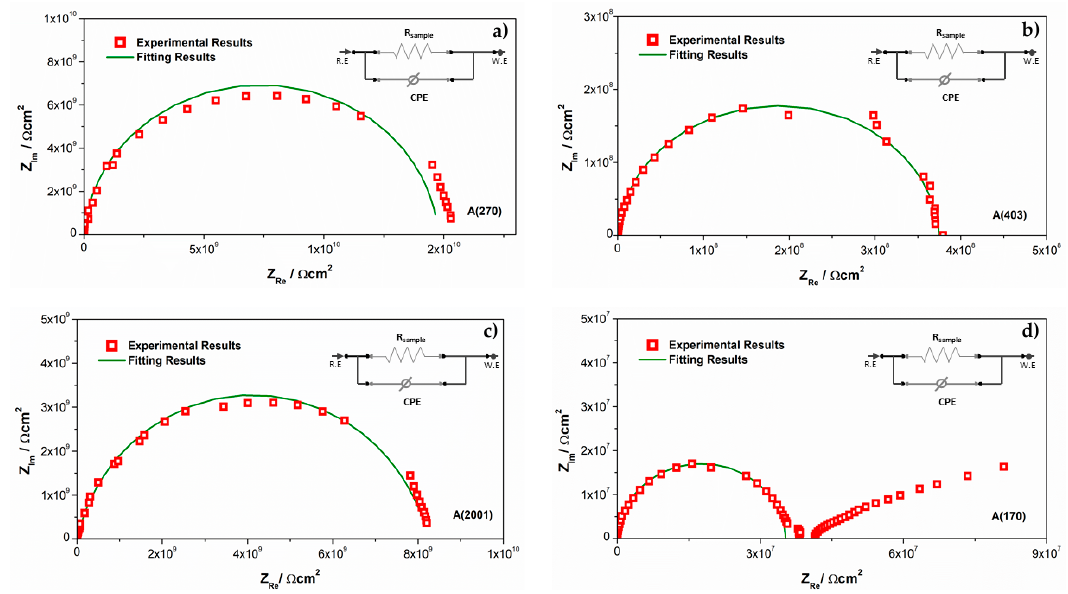
Figure 6. Complex plane impedance plots obtained for the OIH films based on: ( a ) A(270); ( b ) A(403); ( c ) A(2001); and ( d ) A(170) matrices (inset displayed in the EEC (equivalent electrical circuit) diagram adapted for fitting purposes).